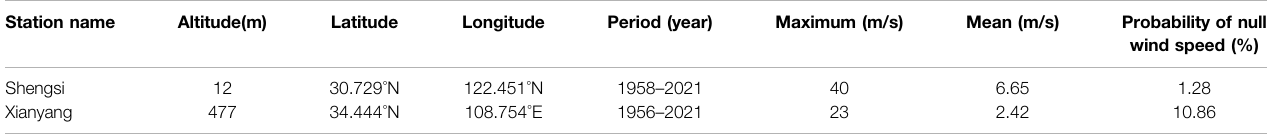
TABLE 1 | The altitude, geographic coordinates, period of record, maximum wind speed, and the probability of null wind speed of the two sites in Shengsi and Xianyang.